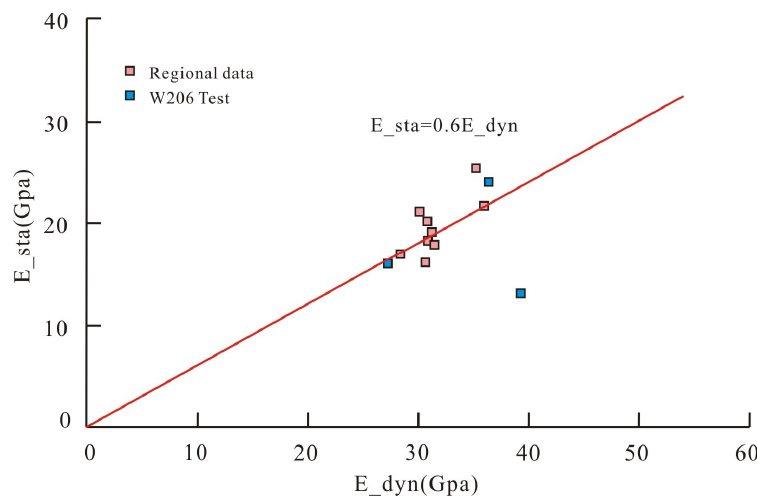
Figure 7. The relationship between the E_sta and E_dyn.